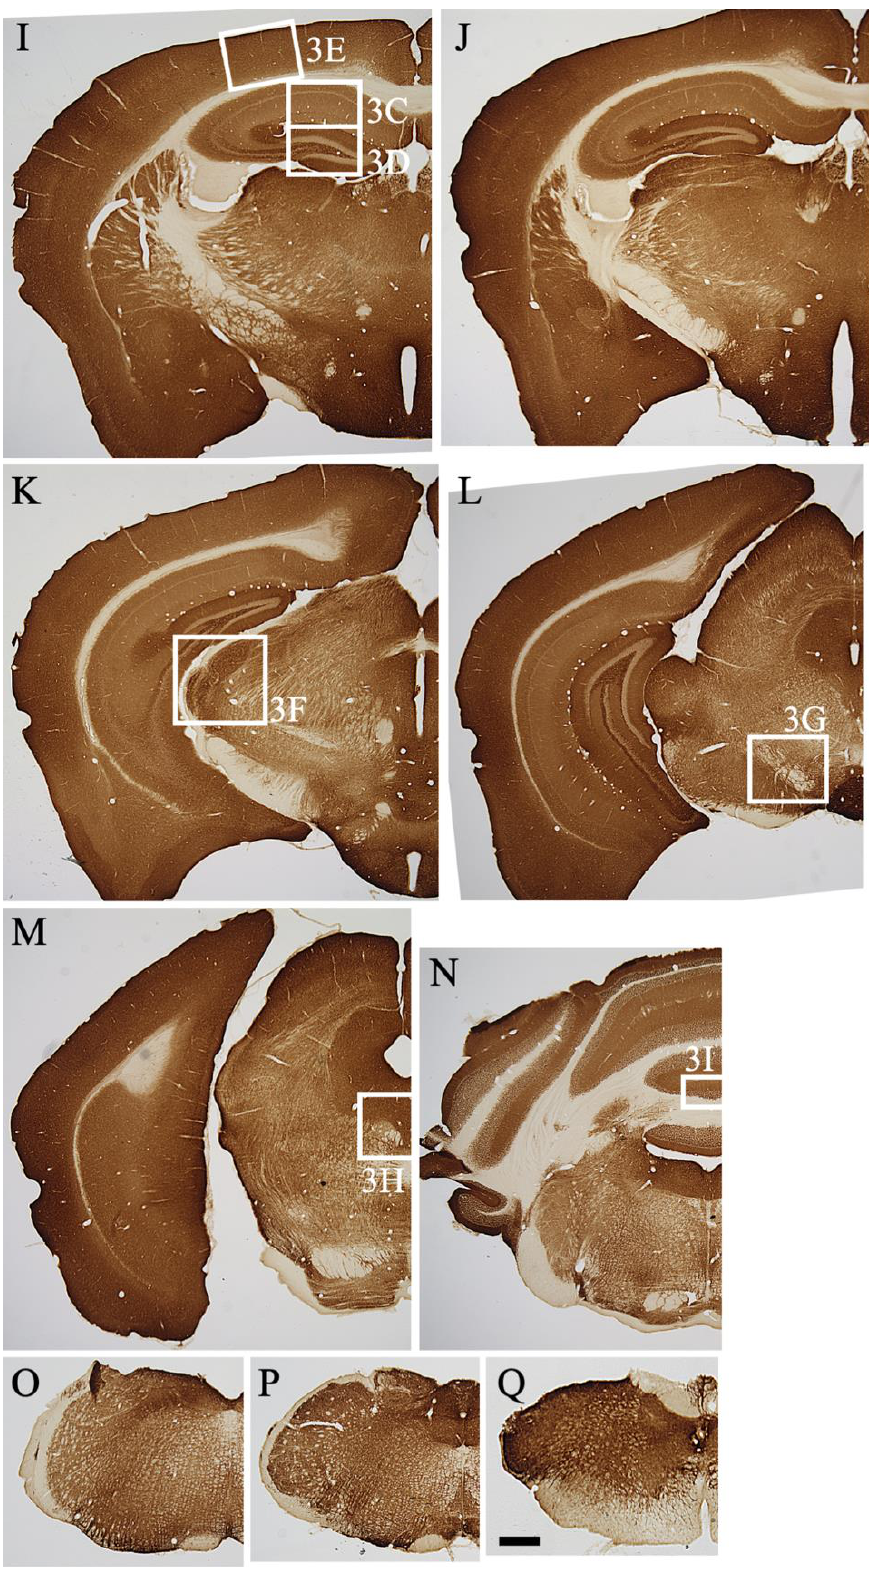
Figure 2. ( A – Q ) Immunoreactivity of MGRN1 in coronal sectioned mouse brain along the rostro- caudal axis is shown. The white boxes indicate the positions of the high magnification images shown in Figure 3. The scale bars in ( H , Q ) are 1 mm.